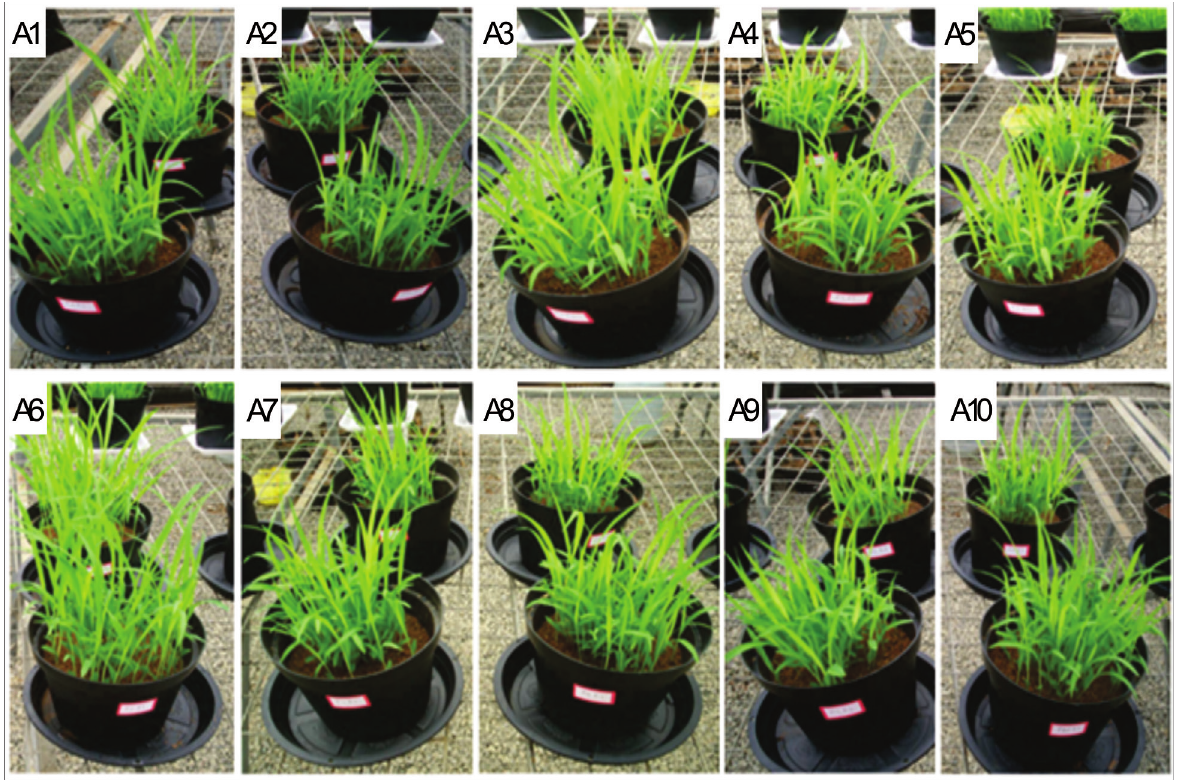
Figure 2 - Trap cultures of soil samples from areas of conventional cotton production system (A1, A2 and A3), native Cerrado biome vegetation (A4, A5 and A6), family-based organic farming system (A7 and A8) and native subcaducifolia forest (A9 and A10), with Brachiaria decumbens as the trap plant for